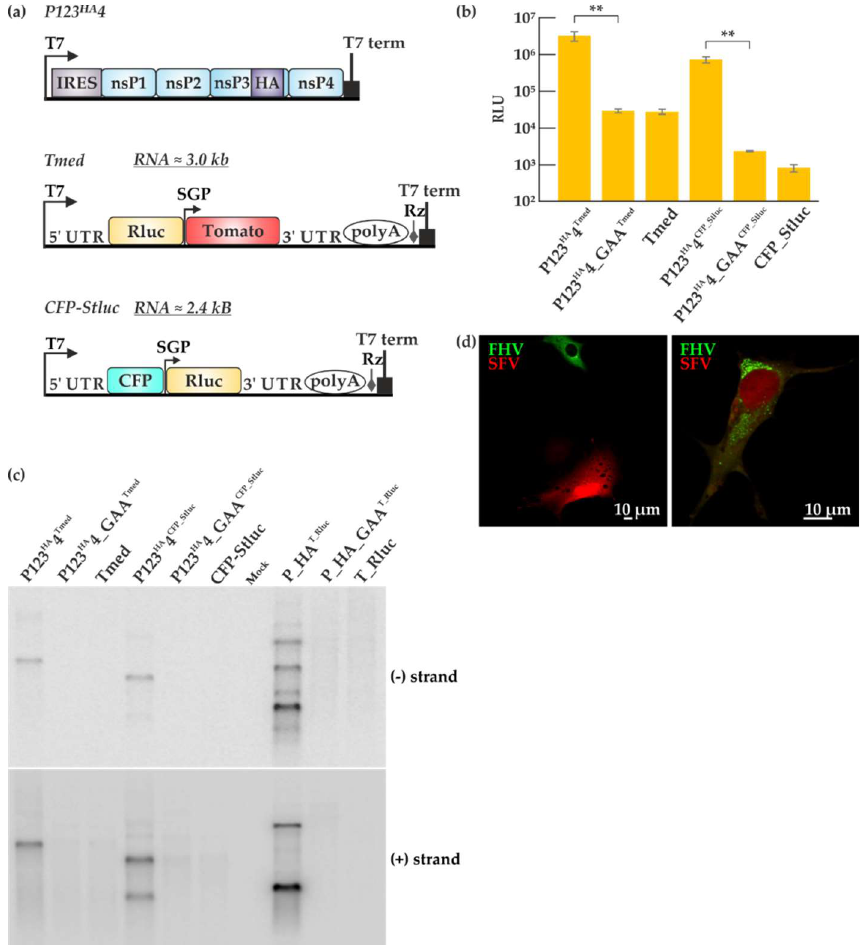
Figure 6. Comparison of Semliki Forest virus (SFV) and FHV trans-replication systems. ( a ) Graphic representation of the SFV trans-replication system. In the two templates used here, Rluc is placed under the genomic or subgenomic promoter. The abbreviations and symbols are as in Figure 1. Non-structural proteins (nsPs) 1–4 represent the SFV replicase proteins. Tomato and cyan fluorescent proteins (CFP) are the fluorescent markers present on the templates. ( b ) BSR T7/5 cells were transfected with the SFV trans- replication systems and incubated at 37 °C for 16 h. Luciferase signals are shown as means from two independent experiments and the mock values have been subtracted. Error bars represent the standard deviation. ** designates p < 0.01 (Student’s t test). The templates used are indicated as superscripts together with the replicase plasmids. ( c ) Viral RNA synthesis was detected by Northern blotting using probes designed to detect negative and positive strands, using probes for the Rluc encoding region, common to all the systems. ( d ) BSR T7/5 cells were transfected with the two replication systems together (P123 HA 4+ Tmed + P_HA + T_eGFP) using Lipofectamine at 28 °C and RNA replication was detected by microscopy 40 h post-transfection. Green fluorescence represents FHV replication while red fluorescence represents SFV replication.